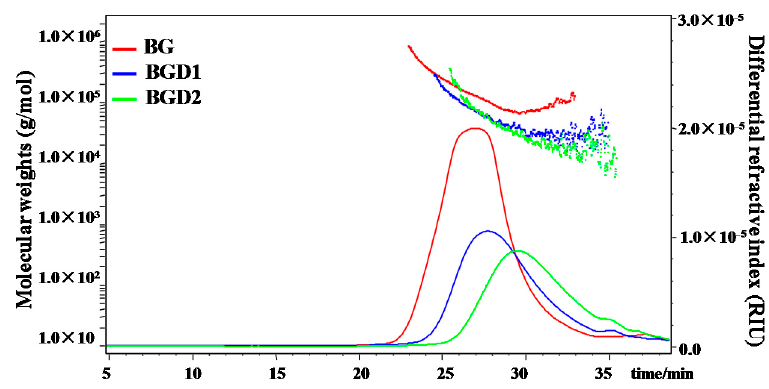
Figure 2. HPSEC-RID chromatograms and molecular weights of Qingke β -glucans. BG , Qingke β -glucan; BGD1 , Qingke β -glucan with acid hydrolysis for 10 min; BGD2 , Qingke β -glucan with acid hydrolysis for 20 min.